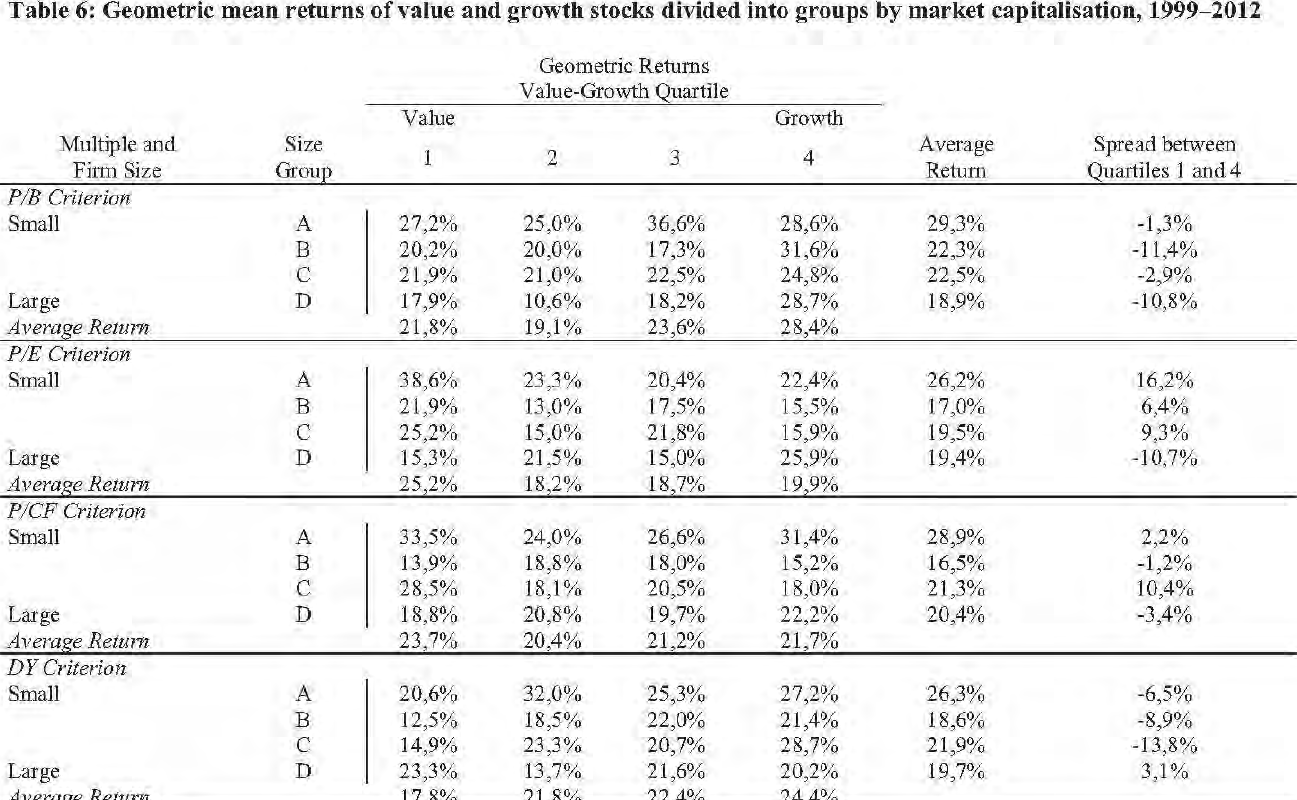
Table 6: Geometric mean returns of value and growth stocks divided into groups by market capitalisation, 1999-2012 Multiple and Size